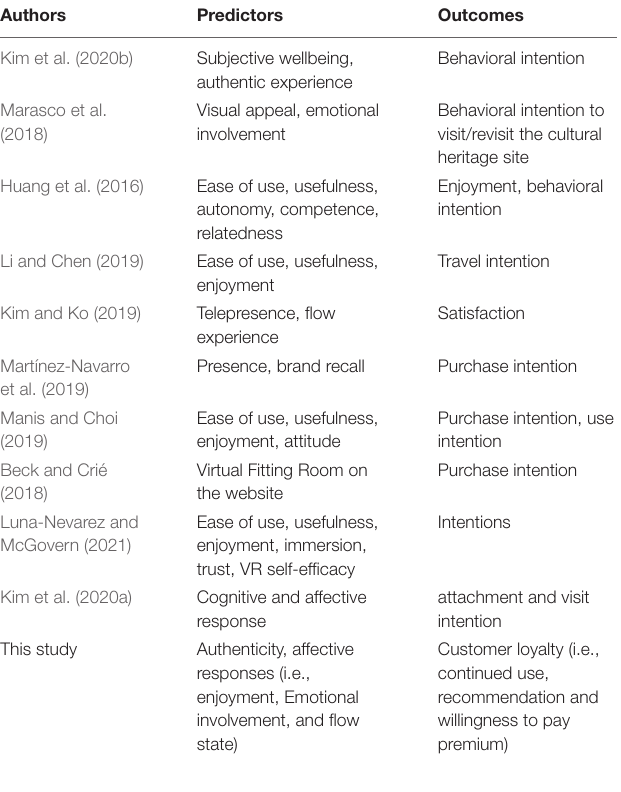
TABLE 1 | Previous research on the predictors and outcomes of VR adoption intention/VR purchase